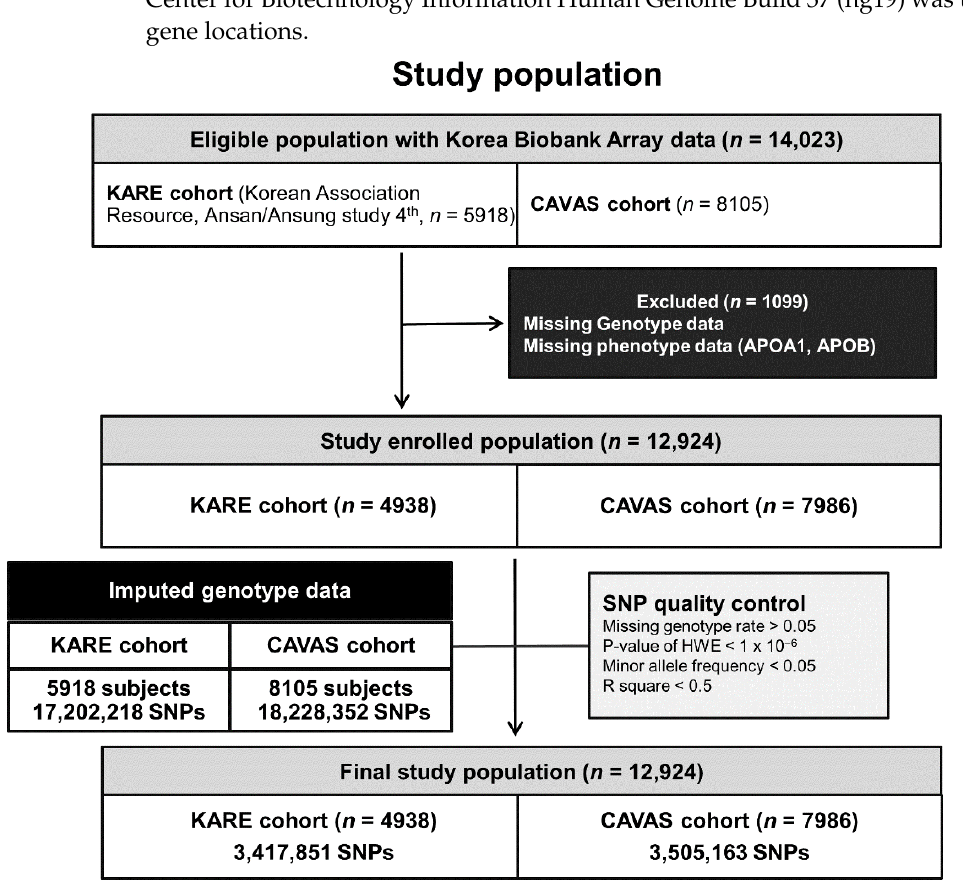
Figure 1. Schematic plot of study design: Meta-analysis of genome-wide association study data. HWE, Hardy – Weinberg Equilibrium.